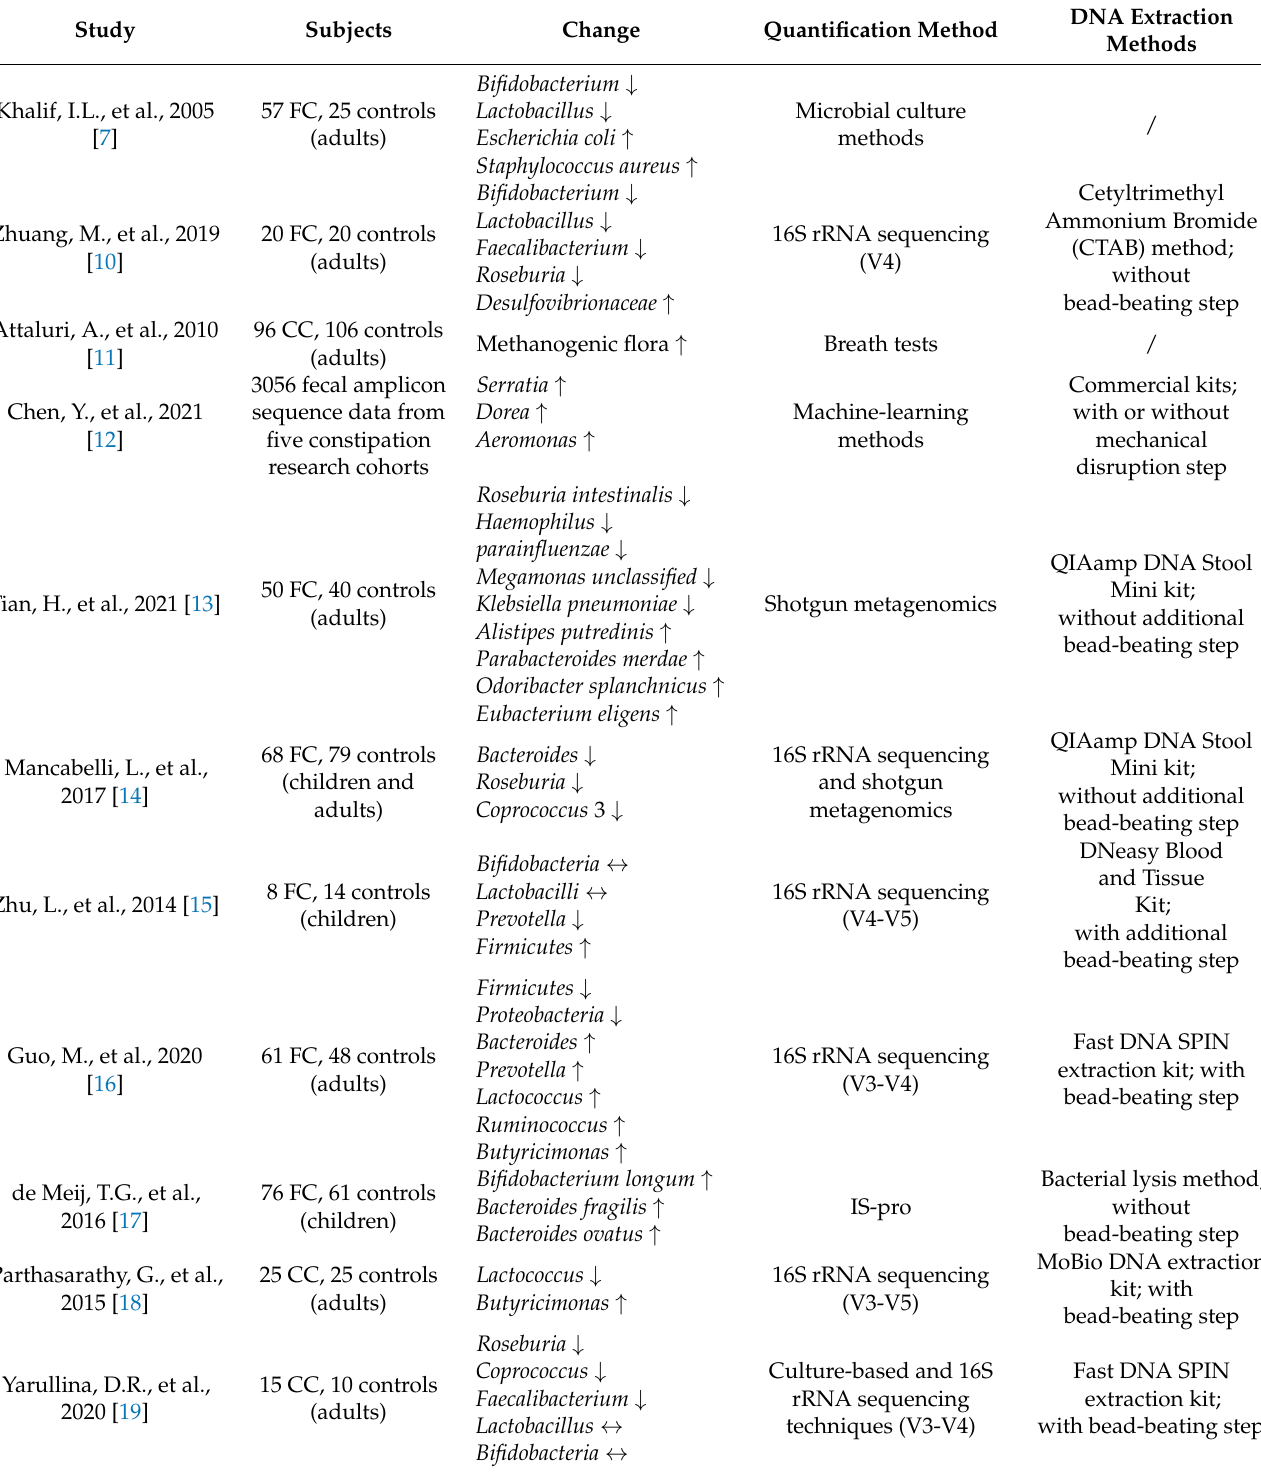
Table 1. Reported alteration in gut microbiome in children and adults with